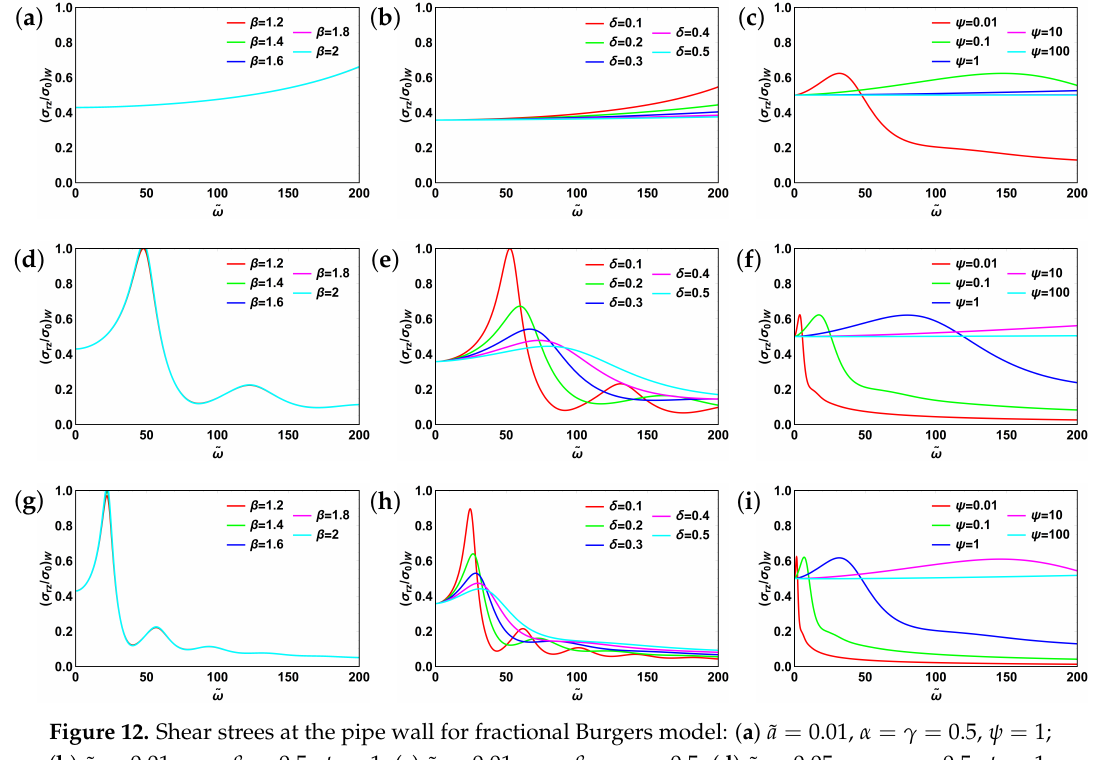
Figure 12. Shear strees at the pipe wall for fractional Burgers model: ( a ) ˜ a = 0.01, α = γ = 0.5, ψ = 1; ( b ) ˜ a = 0.01, α = β = 0.5, ψ = 1; ( c ) ˜ a = 0.01, α = β = γ = 0.5; ( d ) ˜ a = 0.05, α = γ = 0.5, ψ = 1; ( e ) ˜ a = 0.05, α = β = 0.5, ψ = 1; ( f ) ˜ a = 0.05, α = β = γ = 0.5; ( g ) ˜ a = 0.1, α = γ = 0.5, ψ = 1; ( h ) ˜ a = 0.1, α = β = 0.5, ψ = 1; ( i ) ˜ a = 0.1, α = β = γ = 0.5. Subscript “w” stands for